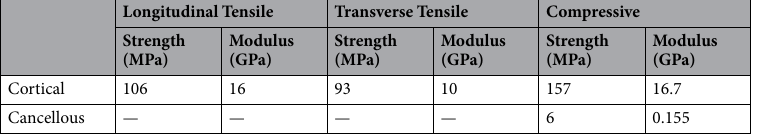
Table 1. Simulated Bone Material Properties. The table shows the material properties used in the FEA presented in this paper. These material properties are provided by Sawbones ® and are based on ASTM D-638 and